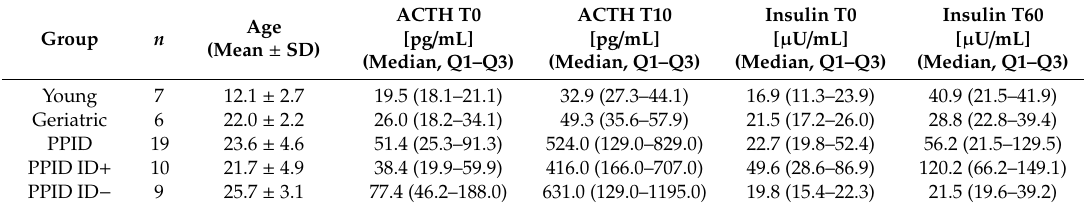
Table 1. Detailed information on study groups and the results of endocrine tests.